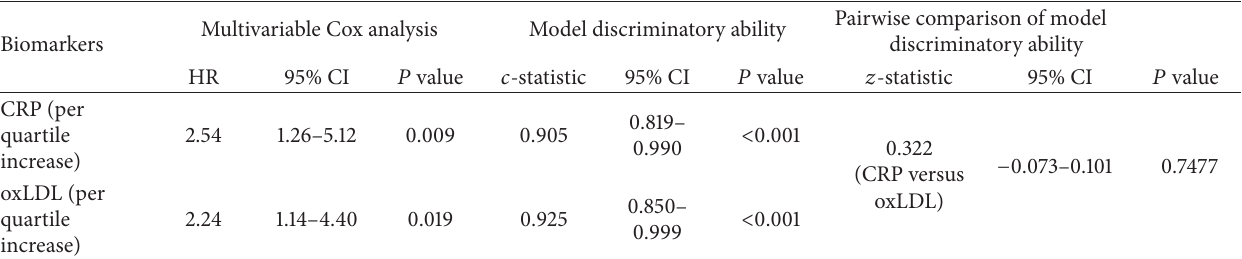
Table 5: Multivariate Cox proportional hazard models for the association of biomarkers with the occurrence of hypertension in lone AF